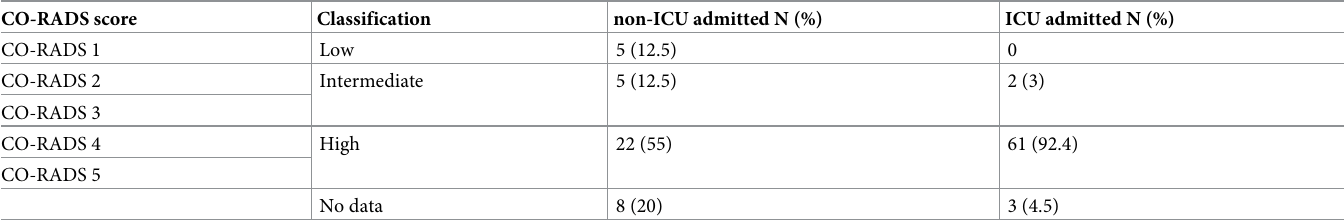
Table 1. COVID-19 Reporting and Data System (CO-RADS) based demarcation among the COVID-19 positive patients. CO-RADS